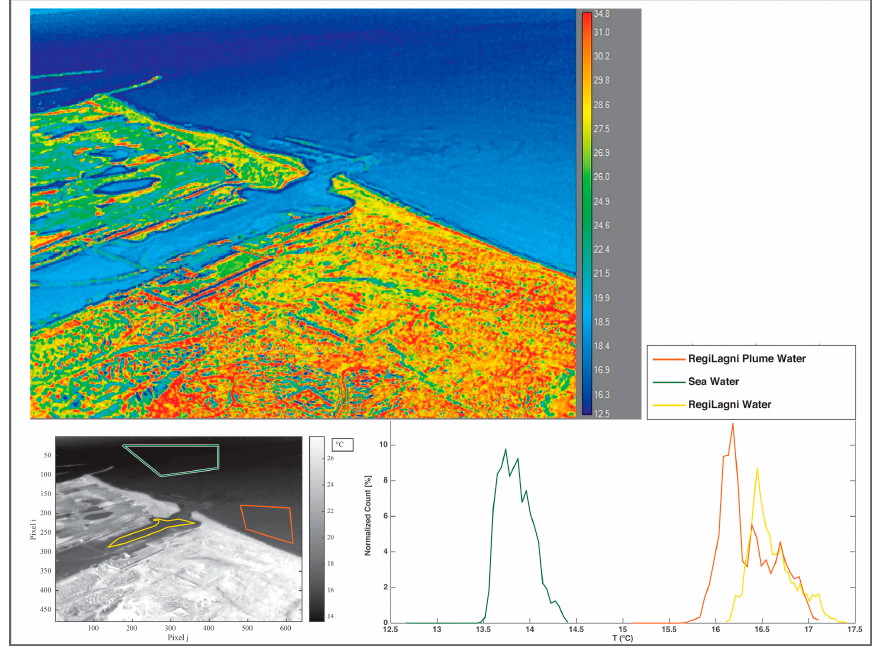
Figure 6. Thermal image of Regi Lagni plume with histogram of radiometric temperature for areas of the channel, seawater, and area of the plume.